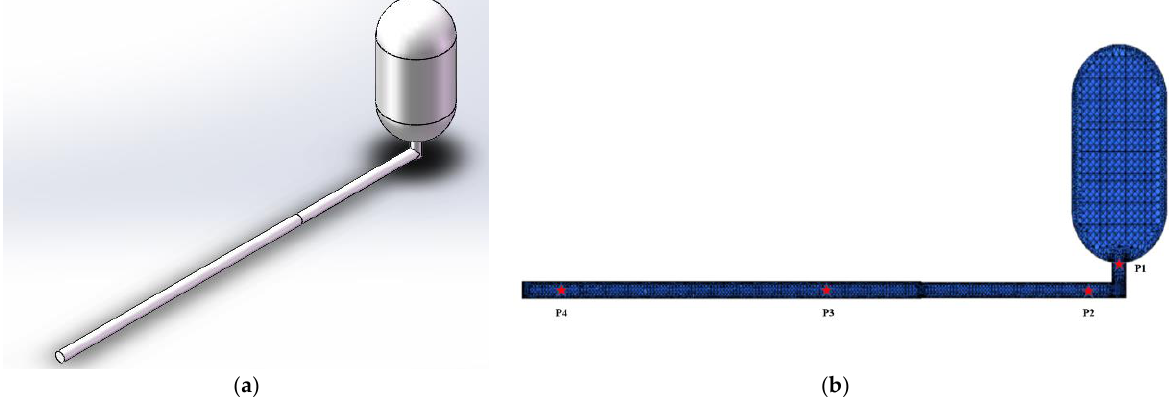
Figure 1. Model of fire-extinguishing system: ( a ) physical model and ( b ) diagram of grids. According to Williamson’s [10] experimental observation, the Halon 1301 and nitro- gen flow in the pipeline is a gas – liquid dispersed bubble flow, and the bubble diameter is less than 0.01 inches. Therefore, in this study, the gas – liquid two-phase flow process was simulated by the mixture model. The flow process of Halon in the pipeline was regarded as a gas – liquid homogeneous and balanced multiphase flow. Each phase shared the same pressure and velocity field, and the slip velocity between phases was ignored. The gov- erning equations describing the flow in the mixture model are presented as follows [20]: Continuity equation: 𝜕 𝜕𝑡 (𝜌 𝑚 ) + ∇ ∙ (𝜌 𝑚 𝑣⃗ 𝑚 ) = 0